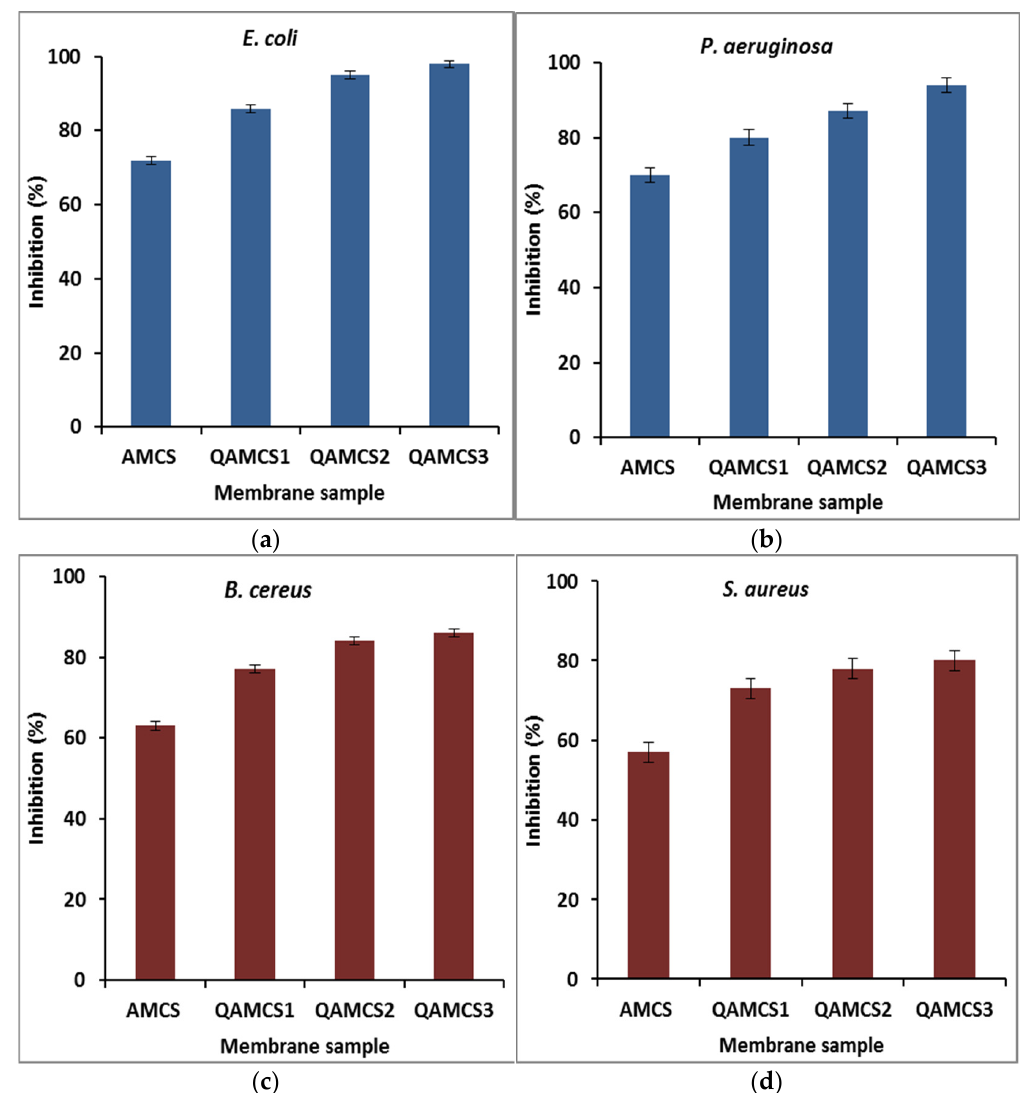
Figure 6. Antibacterial activities of aminochitosan, quaternized aminochitosan 1, quaternized aminochitosan 2 and quaternized aminochitosan 3 membranes against ( a ) E. coli , ( b ) P. aeruginosa , ( c ) B. cereus and ( d ) S. aureus . All measurements were accomplished in triplicate ( n = 3), and data obtained are expressed as means and standard deviations (±SD).